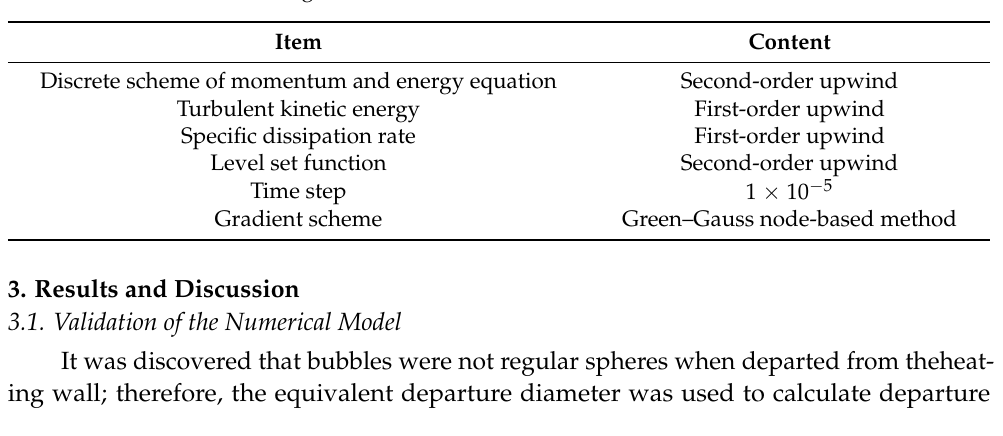
Table 2. More details of